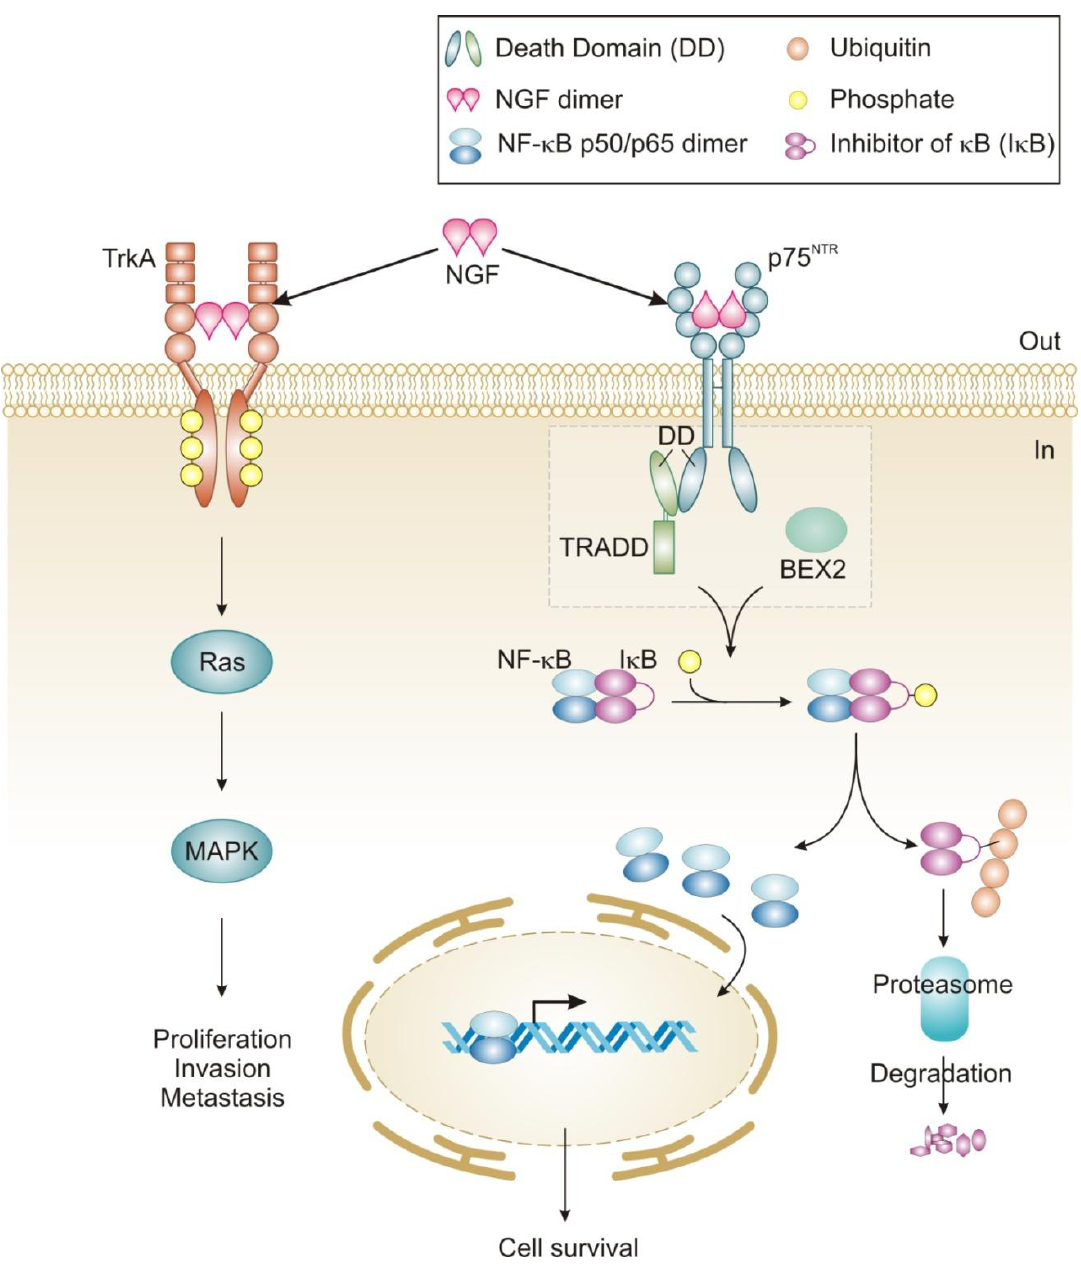
Figure 2. Nerve growth factor (NGF) signaling in breast cancer cells. NGF mediated autocrine signaling in breast cancer cells is carried out by two independent signaling pathways via TrkA and p75 NTR . TrkA signals downstream to Ras/MAPK promoting proliferation of cells, as well as invasion and metastasis. p75 NTR signaling results in activation of the transcription factor NF-κB p50/p65 canonical pathway. The precise mechanism leading to NF-κB activation is not fully understood but is known to include TRADD and BEX2. This activation of NF-κB has been shown to be antagonized by the small peptide inhibitor SN-50. Activation of these pathways ultimately results in changes at transcriptional level. PI3K, Phosphatidylinositol-3-kinase; MAPK, Mitogen activated protein kinase; NF-κB, Nuclear factor-κB; IκB Inhibitor of κB; TRADD, Tumor necrosis factor receptor-associated death domain; BEX2, Brain expressed X-linked 2; DD, death domain; Ub, ubiquitin; P,